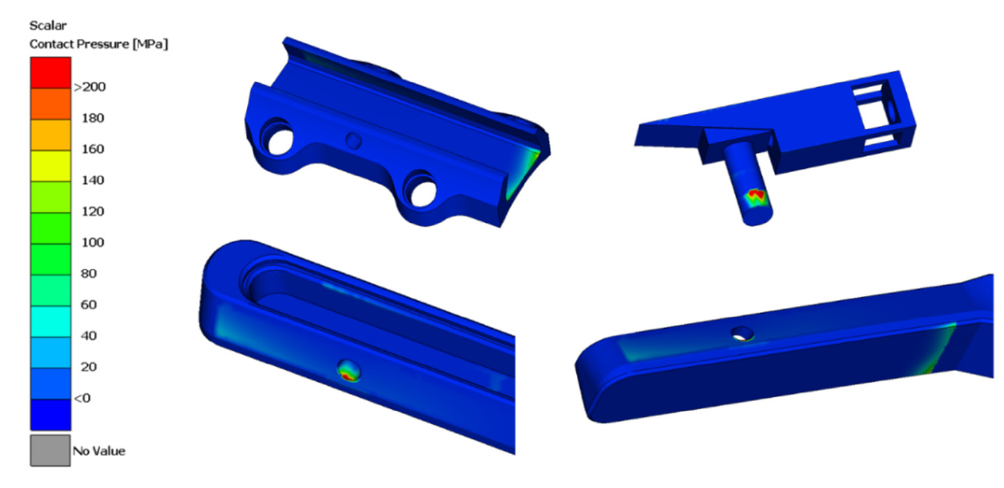
Figure 10. Maximum contact pressure at the experimental peak static load (2 kN): detail of plate components.